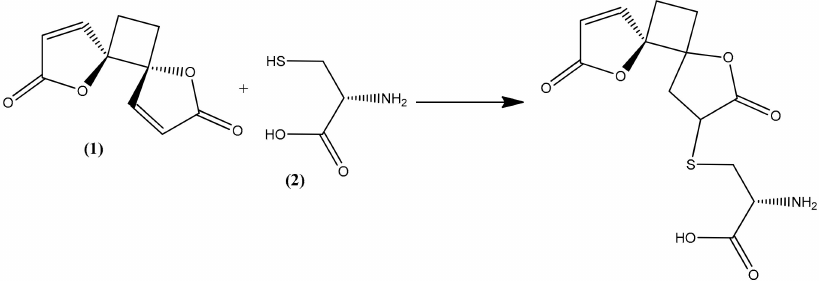
Figure 4. Possible Michael-type addition reaction between anemonin (1) and L-cysteine